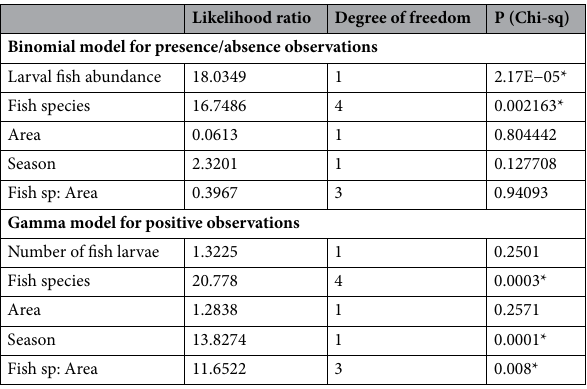
Table 4. Analysis of deviance for the presence and absence (GLM Binomial) and positive frequency (GLM Gamma) of ectoparasite on five fish species ( H. cunninghami , A. crinitus , G. marmoratus , Myxodes sp., O. jenynsi ), two areas (Isla Santa María and Punta Coloso) and two seasons (Spring–Summer and Autumn– Winter). *Significant at P < 0.05.